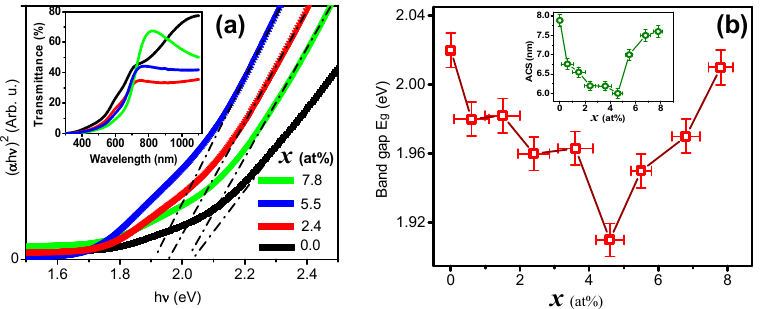
Figure 4. ( a ) Tauc method to calculate the direct energy band gap ( E g ) of the Cd 1- x Er x Se for four values of x . The inset illustrates the optical transmittance ( T o ) spectra for the same samples chosen for E g calculation. ( b ) Direct band gap as function of x , the inset depicts the average crystal size (ACS) versus x plot.